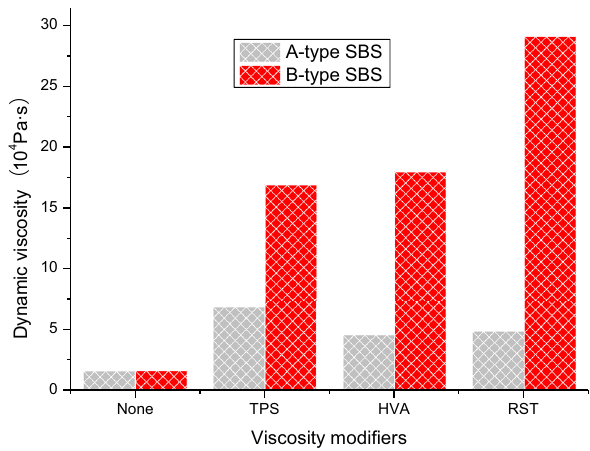
Fig. 4 Effects of different viscosity modifiers on SBS